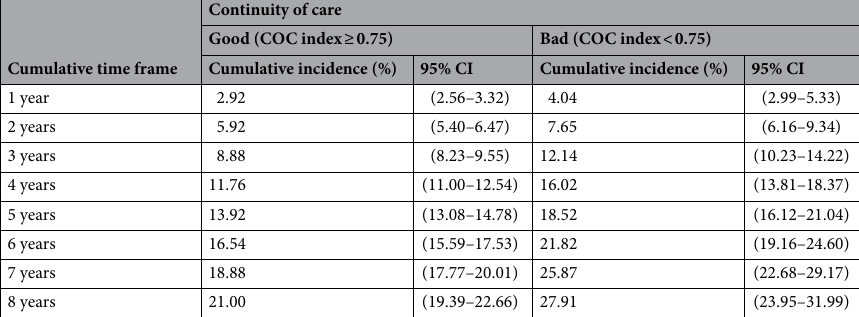
Table 2. Cumulative incidence (%) of major osteoporotic fracture in patients with newly developed rheumatoid arthritis. Cumulative incidence was estimated using the Aalen-Johansen estimator. COC continuity of care, CI confidence interval.